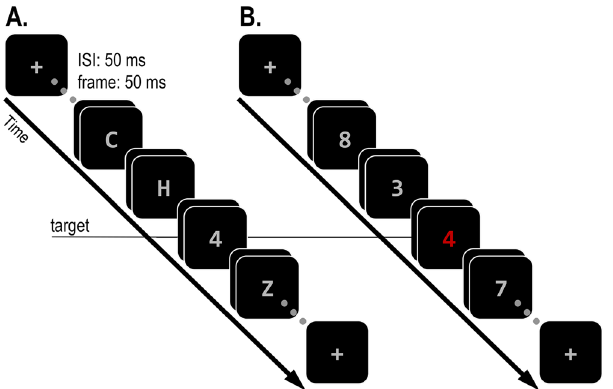
Figure 1. Examples of a traditional RSVP task ( A ) and of a distractor intrusion task ( B ). In both examples, participants have to report the identity of a target digit. In the traditional task, the target is embedded among distractor letters. In the distractor intrusion task, the target is defined by its colour and embedded among distractor digits. Therefore, distractors in the second task can be erroneously reported instead of the target.